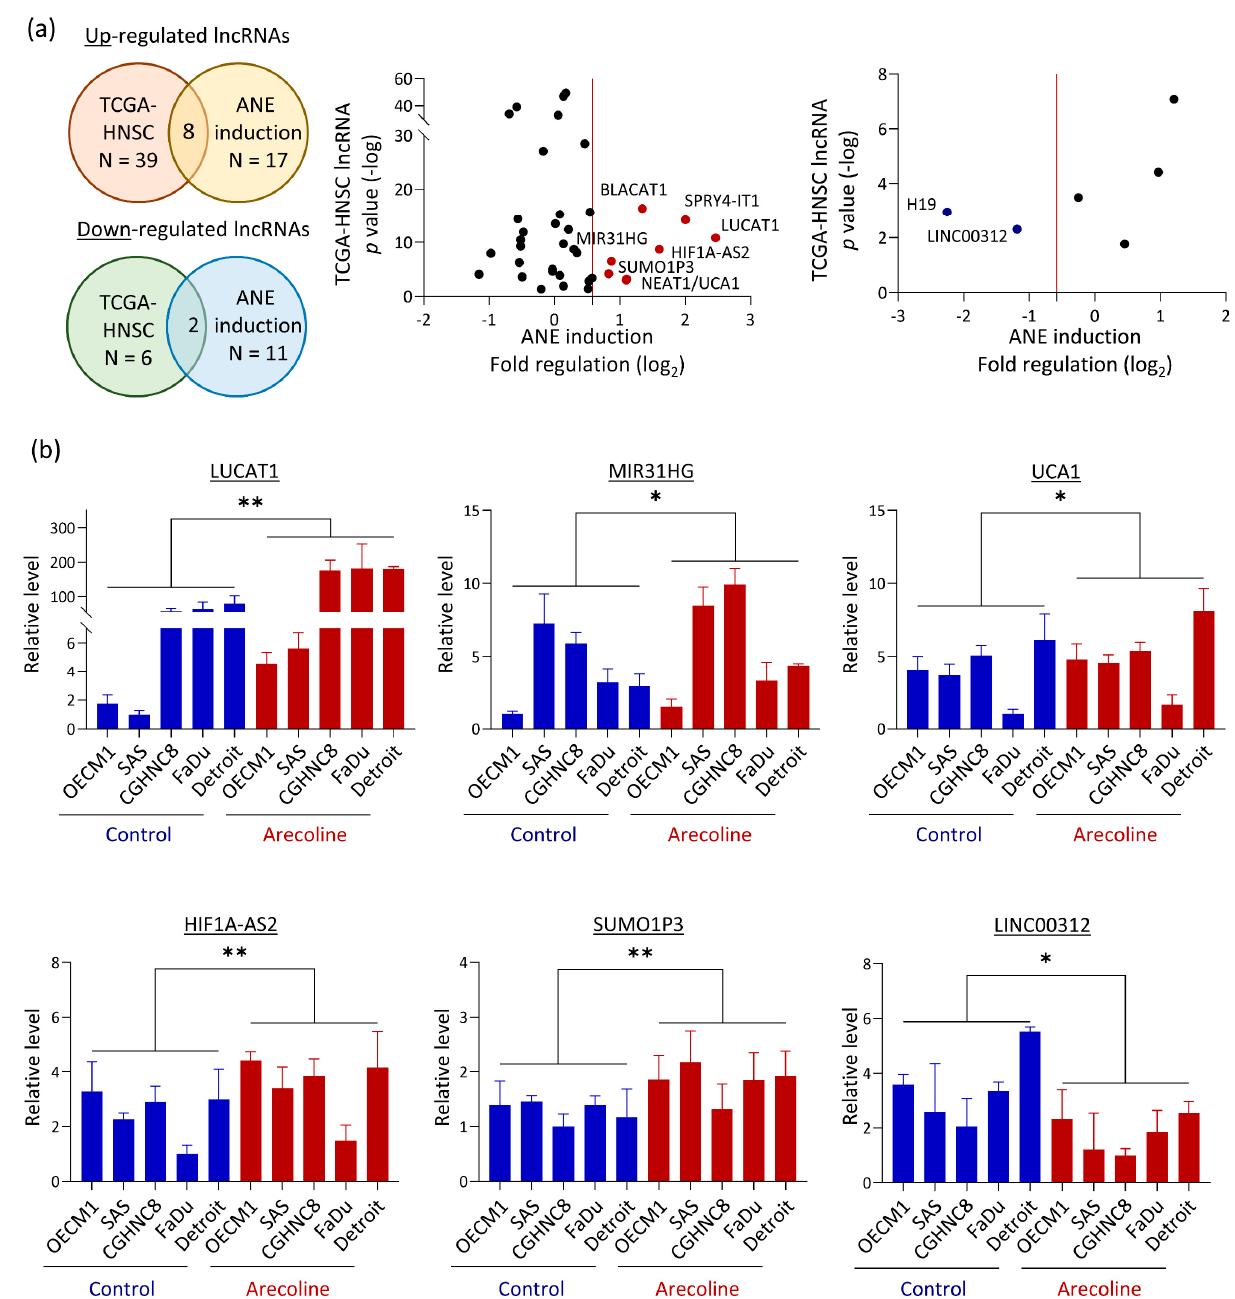
|fold regulation| > 1.5 in the ANE treatment panel and p < 0.05 in TCGA-HNSC dataset (Figure 3a). These combined lncRNAs included eight oncogenic features: upregulated by areca nut and overexpressed in tumors, and two with tumor-suppressive behaviors: downregulated by areca nut and underexpressed in tumors.